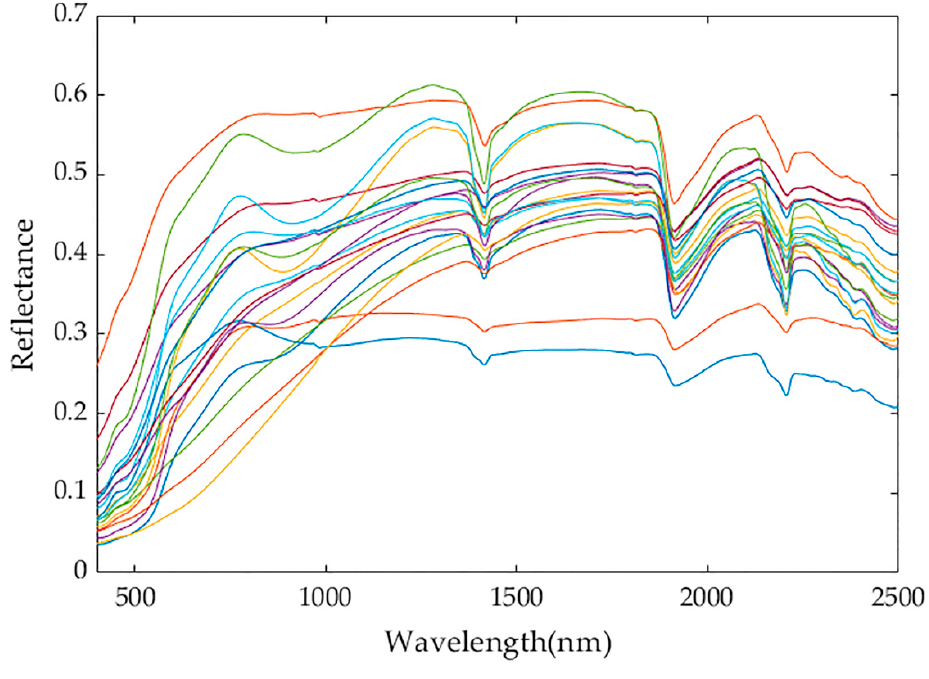
Figure 4. The final extracted 20 soil reflectance curves.